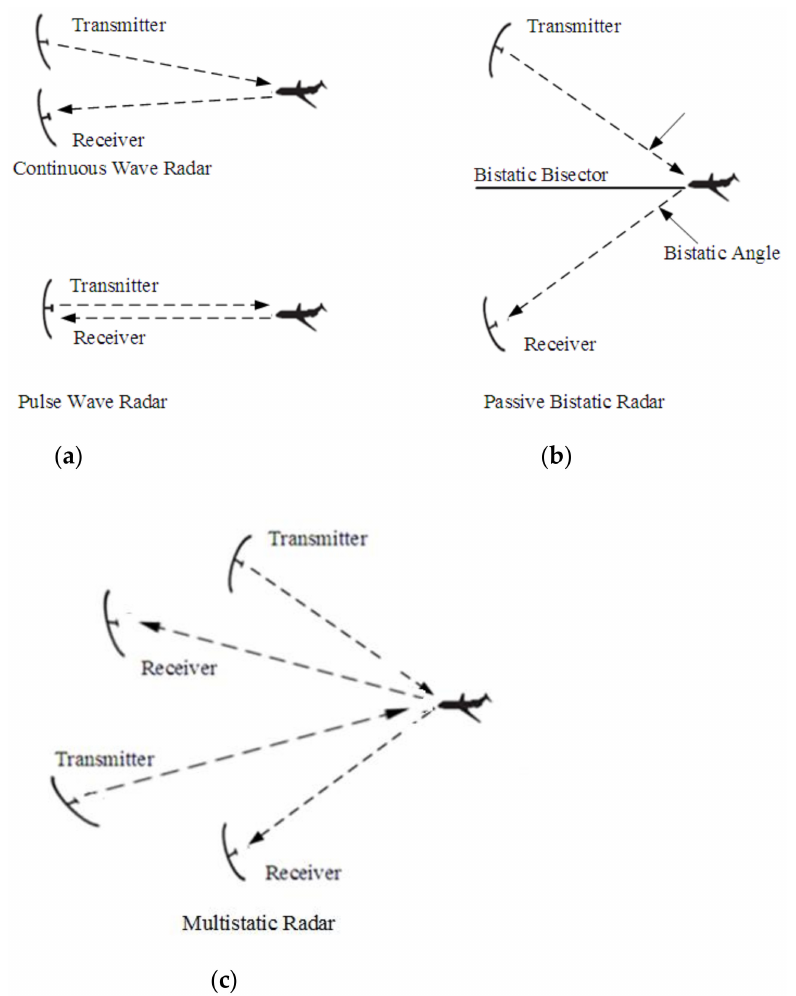
Figure 1. A type of radar systems ( a ) Monostatic ( b ) Bistatic and ( c ) Multistatic